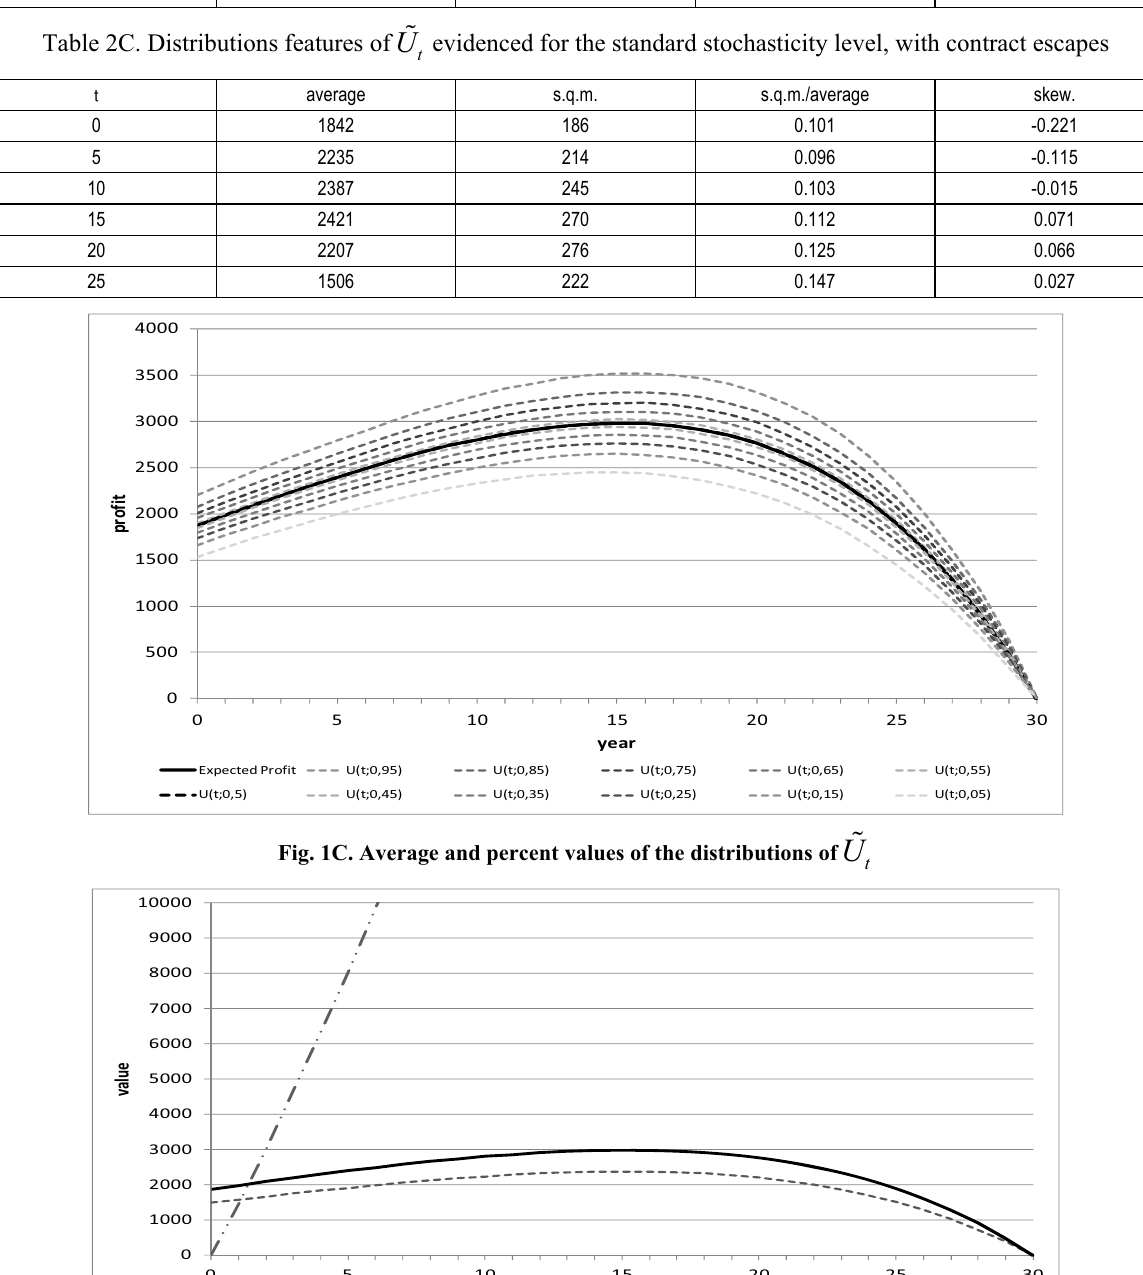
Table 2C. Distributions features of